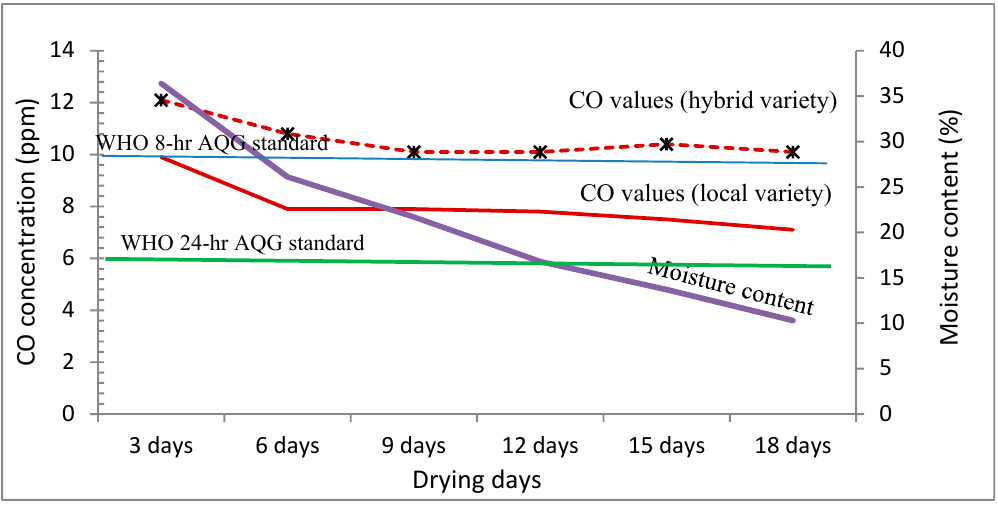
Figure 8. Graphs of CO and moisture content of the hybrid and local coconut wastes.